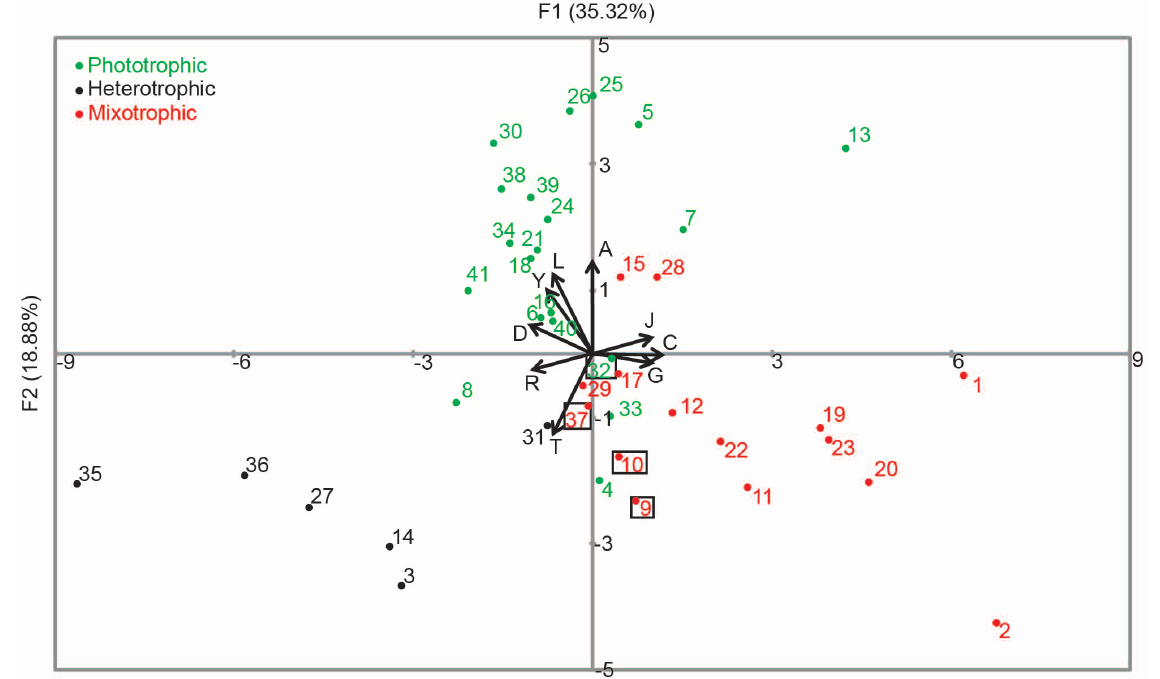
Figure 6. Principal component analysis (PCA) plot of the KOG distributions of the four prymnesiophytes in this study and of other protistan genomes and transcriptomes. The same dataset from Fig. 5 was used to generate this figure. The color scheme and species identification by numbering also correspond to Fig. 5. Explained cumulative variability for this plot was 54.2%, with eigenvalues of 8.5 (F1) and 4.5 (F2). Only top variables for F1 and F2 are plotted in the